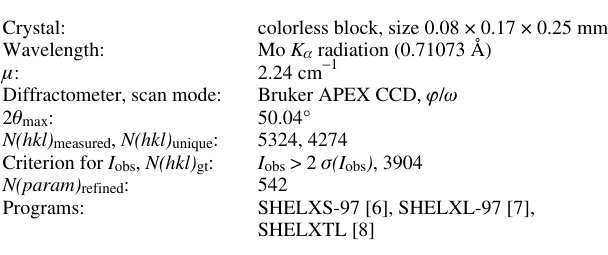
Table 1. Data collection and handling.